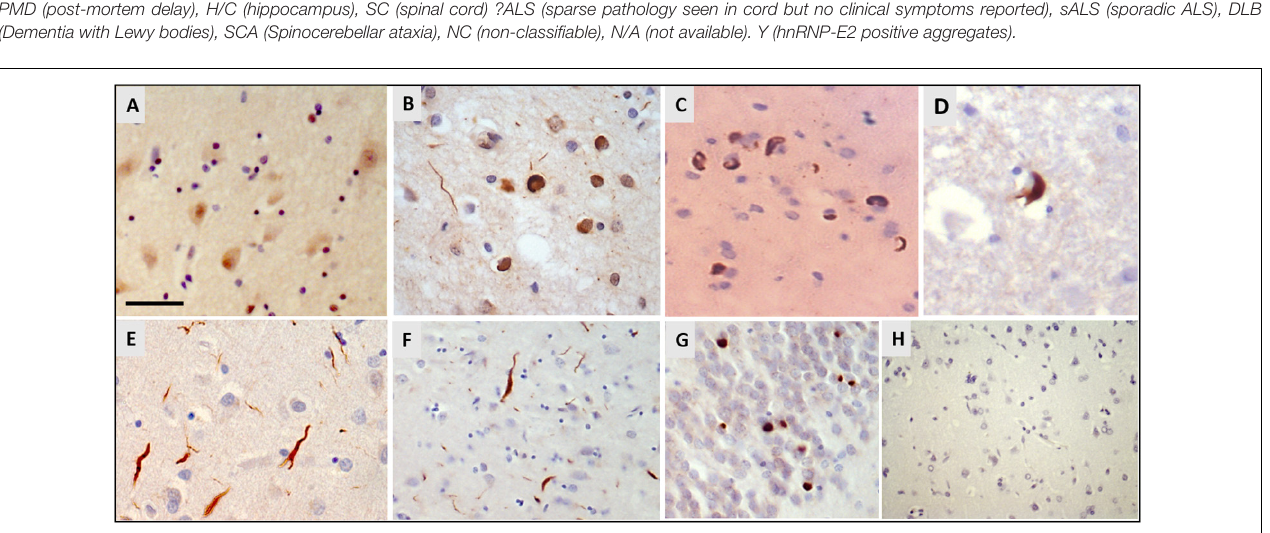
the complete co-localisation of both TDP-43 and